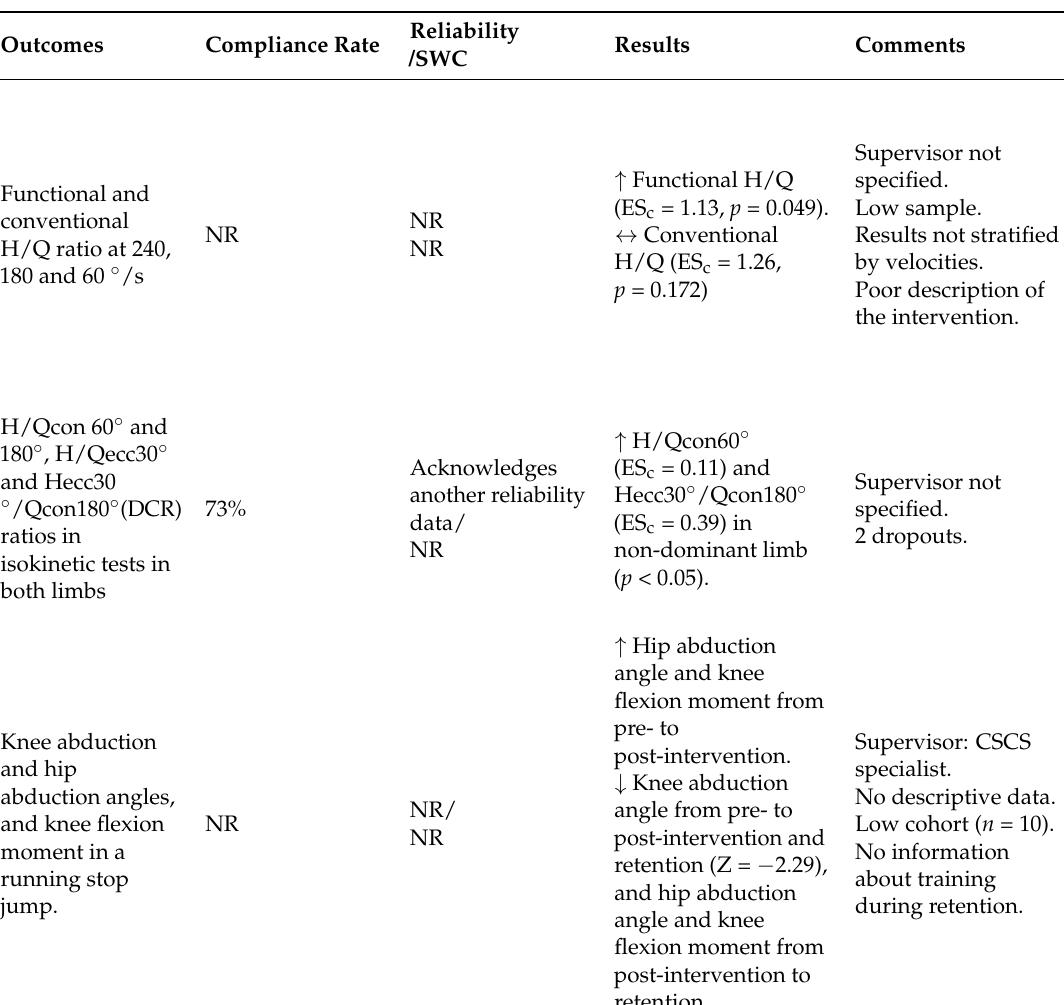
Table 4. Characteristics of the single-arm studies included in the systematic